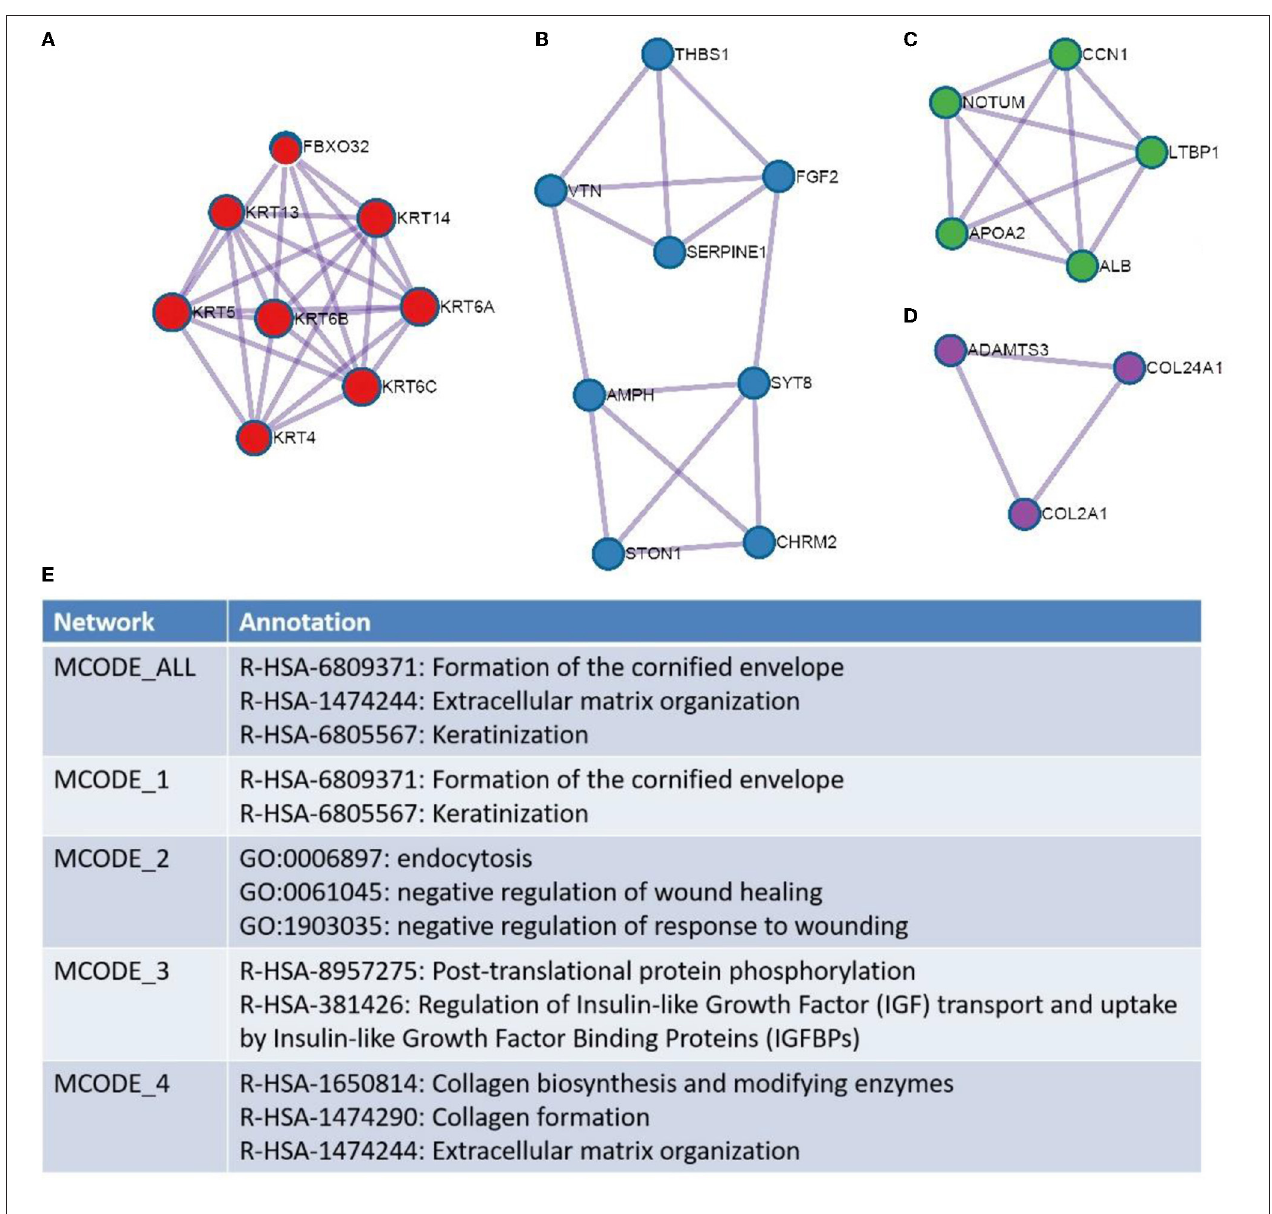
FIGURE 5 | Protein–protein interaction network is shown for: (A) MCODE 1, (B) MCODE 2, (C) MCODE 3, and (D) MCODE 4. The resultant network contains the subset of proteins that form physical interactions with at least one other member in the list. If the network contains between 3 and 500 proteins, the Molecular Complex Detection (MCODE) algorithm has been applied to identify densely connected network components. Gene ontology enrichment analysis was applied to each MCODE network for (E)